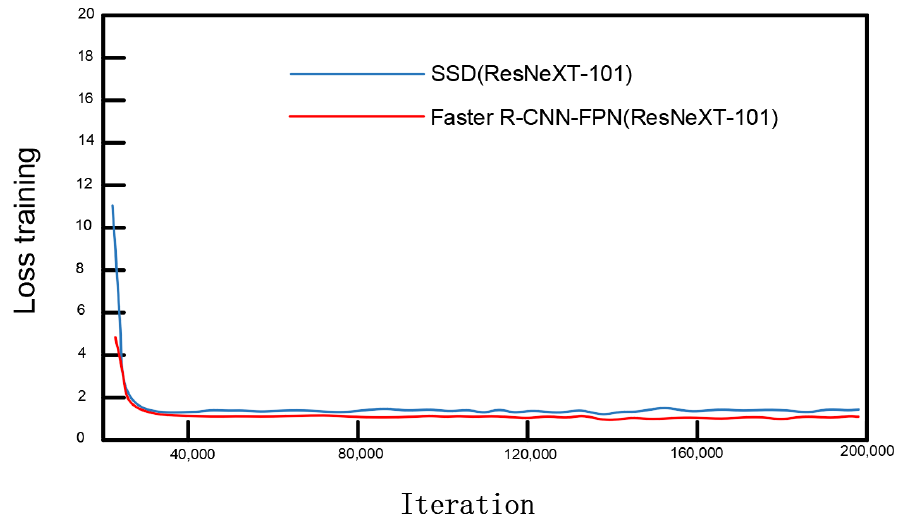
Figure 11. Comparison of the overall losses of the Faster R-CNN and SSD models.